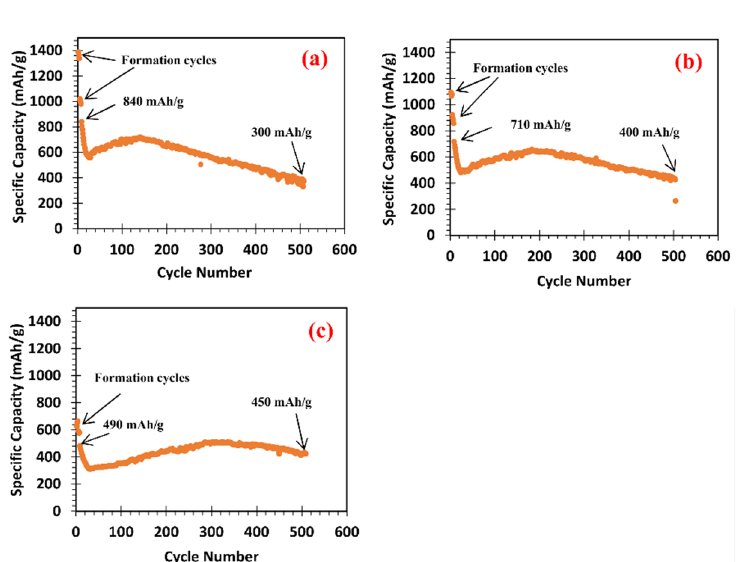
Figure 4. The specific capacity as a function of cycle numbers: ( a ) M1 cell, ( b ) M2 cell, and ( c ) M3 cell. All of them are made of Si@void@C powder without particle classification. Further, all of them have the same service cycles. The different specific capacities and cycle stabilities are due to different lower cutoff voltages in formation cycles. See Table 2 for detailed charge/discharge protocols. The specific capacities at the 1st and 500th service cycles are indicated for each cell.